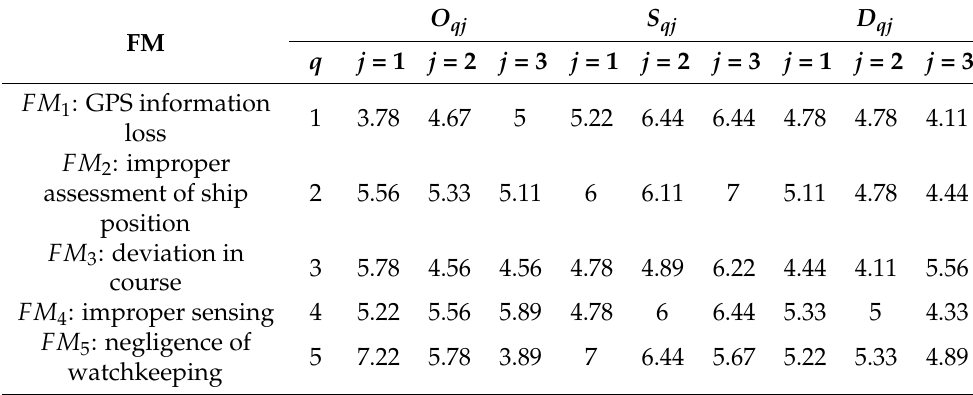
Table 7. RPNs of identified FMs in the three OMs.